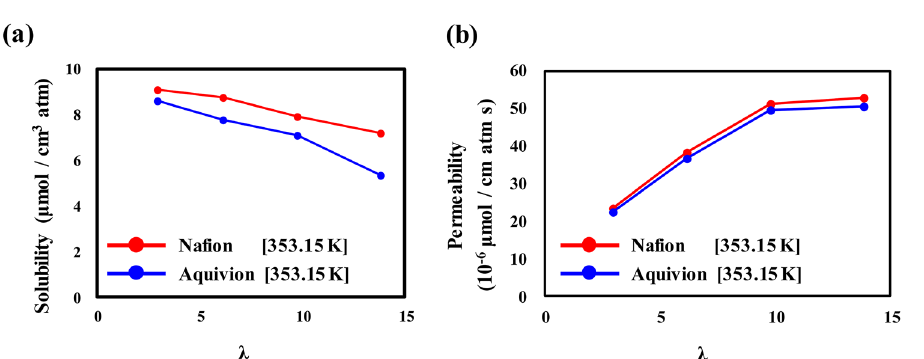
Figure 6. O 2 ( a ) solubility and ( b ) permeability in hydrated Nafion and Aquivion on a Pt (111)